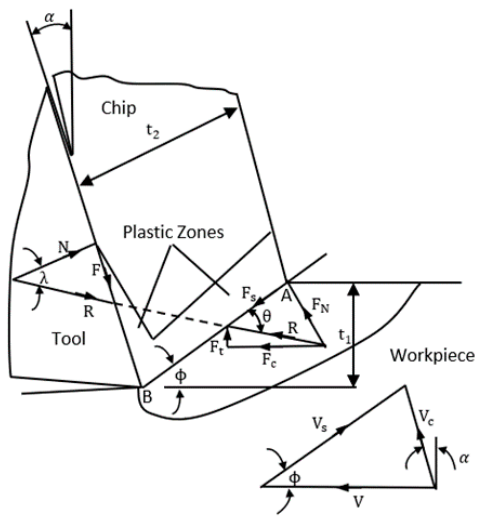
Figure 1. The chip formation model for orthogonal cutting [34].